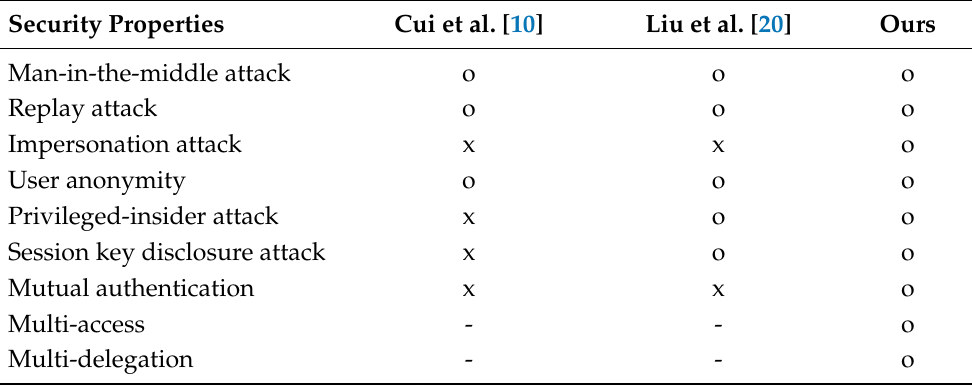
Table 3. Security